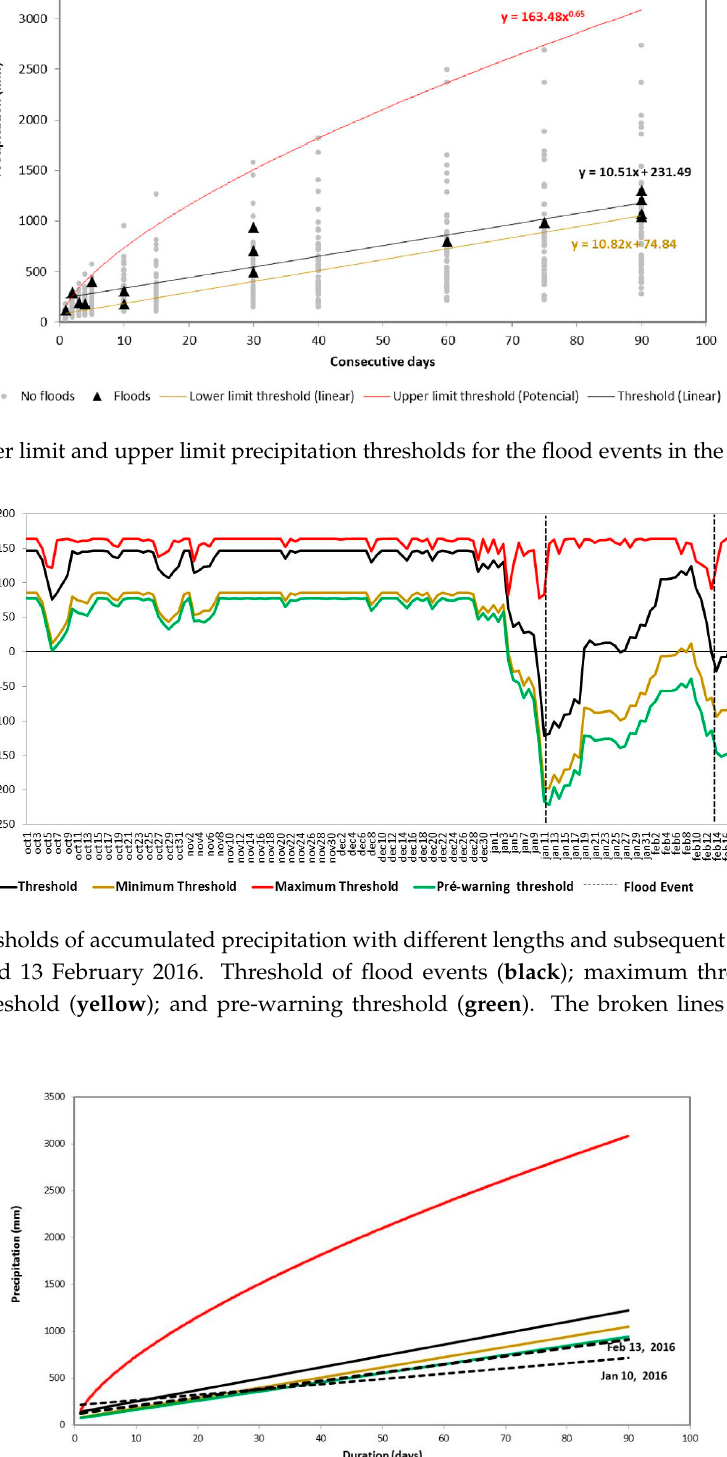
Figure 7. Minimum daily precipitation necessary to overcome the different thresholds of precipitation and flood events in 10 January and 13 February 2016. Thresholds based on flood events ( black ); maximum threshold ( red ); minimum threshold ( yellow ); and pre ‐ warning threshold ( green ). The broken lines indicate the flood events.